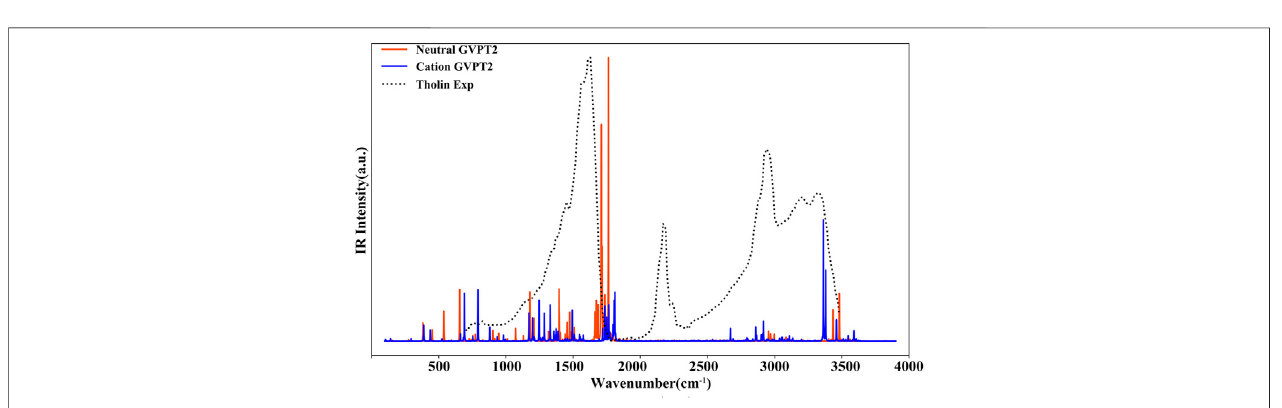
FIGURE8| Comparison ofthesimulated IRspectrum ofthyminewith theexperimentalspectrum ofTholins(Gautier et al.,2012). GVPT2//B2PLYP//B3LYP/AVTZ stick spectra were broadened by Lorentzian functions with HWHM of 1 cm − 1 .